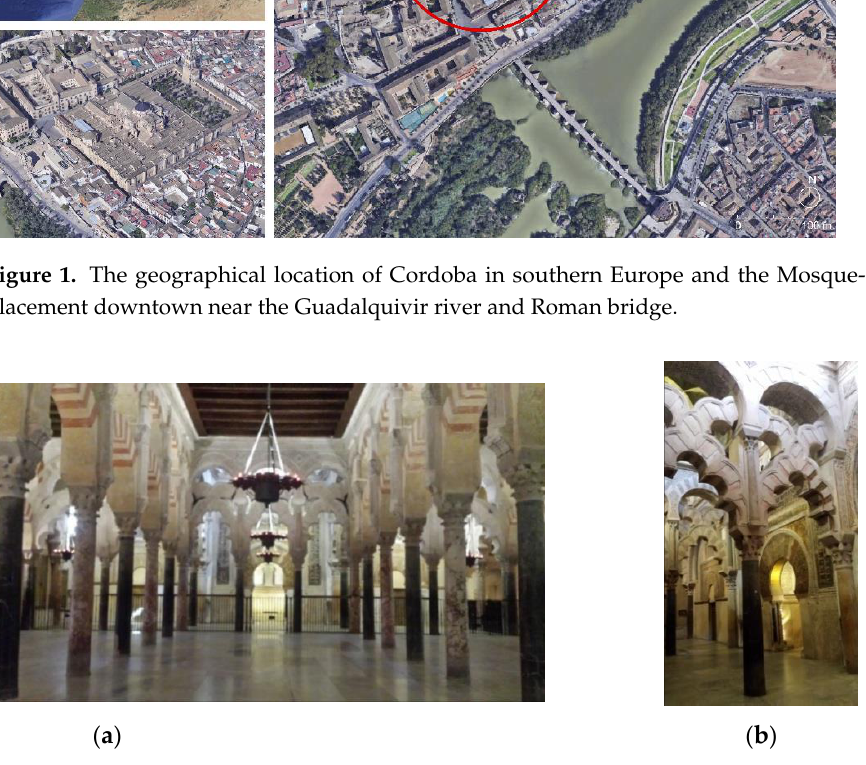
Figure 2. Inner view: ( a ) Mihrab front and ( b ) Mihrab side. Source: Own photographs.